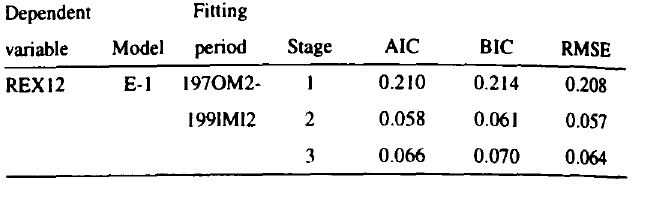
Table 2 Forecast evaluation statistics over